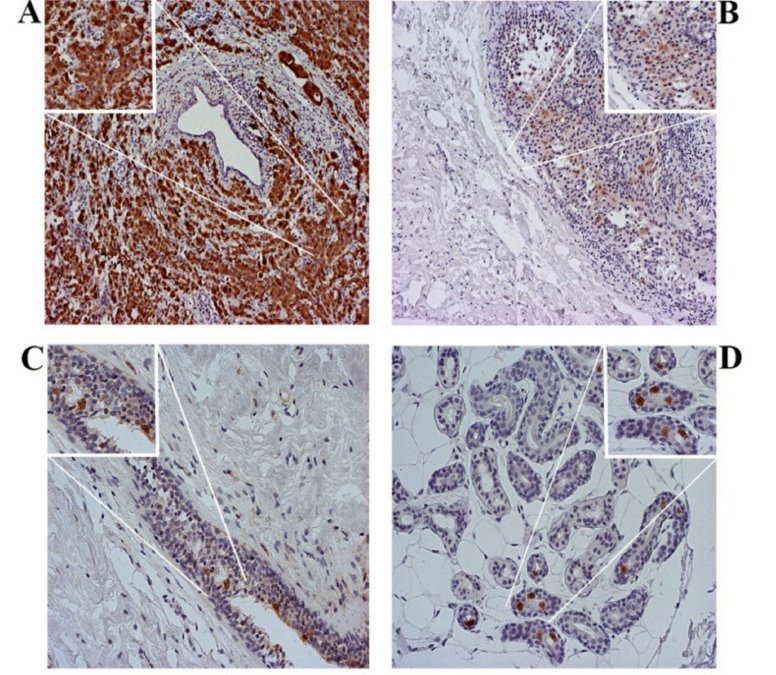
Figure 5. p16 IHC, different subcellular localizations. ( A ) IBC—dominant cytoplasmic staining. ( B ) ISC—dominant cytoplasmic staining, with individual nuclear staining. ( C ) AH—dominant nuclear staining and individual cytoplasmic staining. ( D ) NE—nuclear staining (original magnification 200 ×